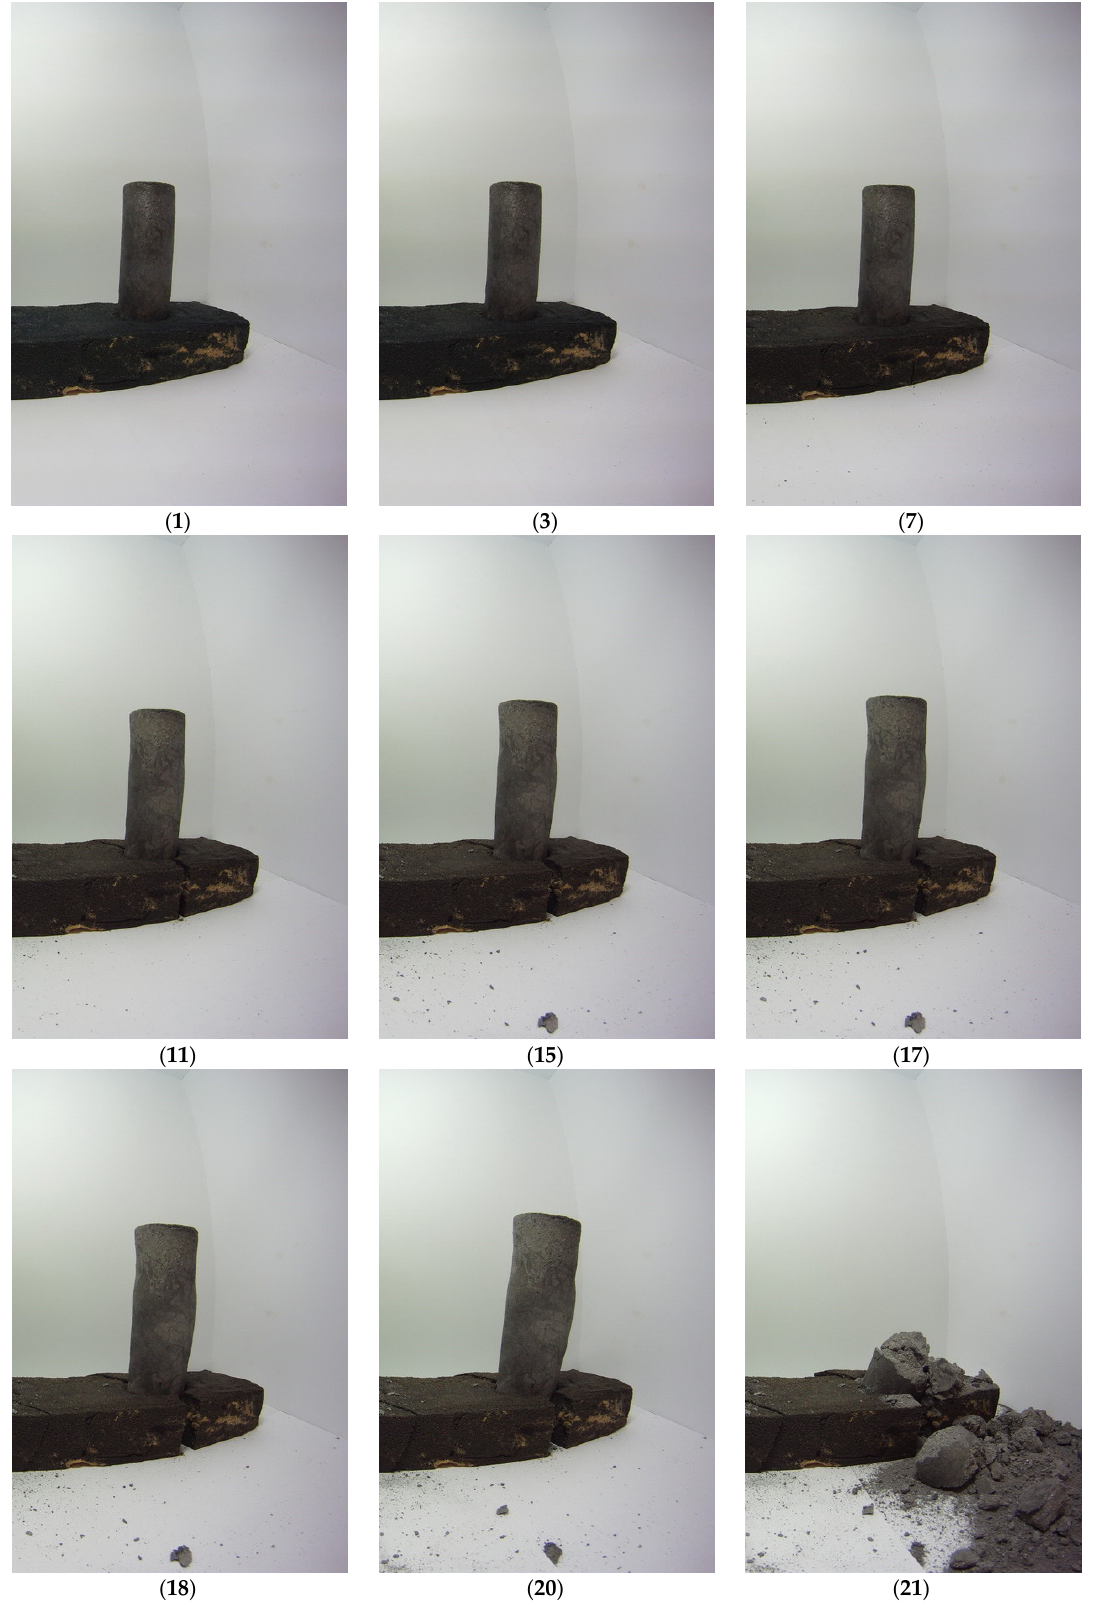
Figure 4. Spontaneous decay of high-aluminum cast iron; the number underneath of the photo shows the day the photo was taken.